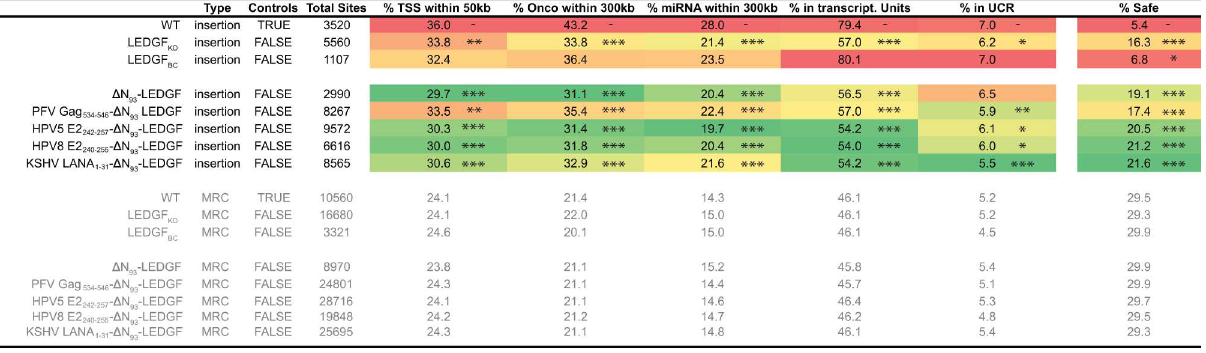
Fig 7. Integration frequency near safe harbor criteria. Fig showingthe percentageHIV-derivedlentiviral vector integrationfrequencies near features (TSS, Oncogenes [66], miRNA encodingregions, Transcription units and ultra conservedregions) that, when hit, are considered to be UNsafe as defined in [59] (Dataset details are describedin the MM section). As such these features are used to define safe harbors as regionsthat fall outside these criteria. Percentagesdepict the fraction of integrations falling within the corresponding range relative to the criteria. The % of integrationsnegativelyassociated with these 5 features is used to calculate a safety profile. ( * , p-value < 0.5; ** , p-value < 0.05; *** , p-value < 0.005, Pearsons Chi-square compared to LEDGF WT control). TSS, Transcription start sites; UCR, Ultra conserved regions; PFV, Prototype foamy virus; HPV, Human papillomavirus; KSHV, Kaposi’s sarcoma herpes virus; LANA, Latency associated nuclear antigen; MRC, matched random control.